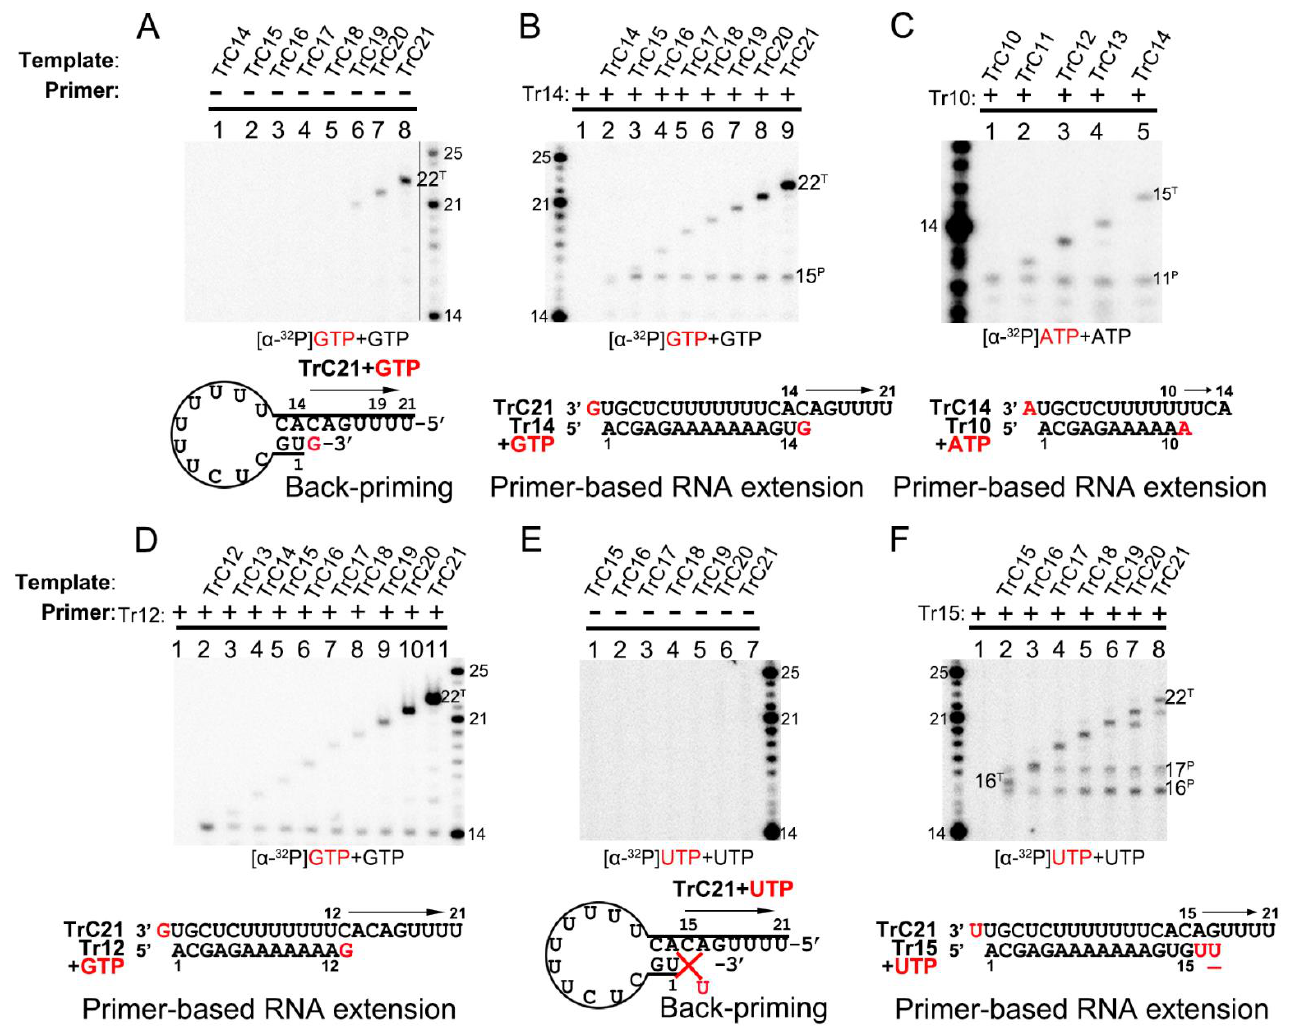
Figure 4. Terminal nucleotide(s) addition to the templates and primers by RSV polymerase. ( A ) Back-primer secondary-structure-based 3 (cid:48) terminal extension of the templates from TrC14 to TrC21 using GTP only. GTP at 50 µ M with 5 µ Ci of [ α -32P] GTP was used in the reaction mixtures. ( B ) Primer-based terminal extension of the templates from TrC14 to TrC21 with primer Tr14 and GTP only. GTP at 50 µ M with 5 µ Ci of [ α -32P] GTP was used in the reaction mixtures. ( C ) Primer-based terminal extension of templates from TrC10 to TrC14 with primer Tr10 in the presence of ATP. ATP at 50 µ M with 5 µ Ci of [ α -32P] ATP was used in the reaction mixtures. ( D ) Primer-based terminal extension of templates from TrC12 to TrC21 with primer Tr12 in the presence of GTP. GTP at 50 µ M with 5 µ Ci of [ α -32P] GTP was used in the reaction mixtures. The 5 (cid:48) hydroxyl RNA (RNA products extended from template or primer) migrates about 1 nt slower than 5 (cid:48) monophosphate RNA (RNA ladders) when the RNA length is 12–24 nts (See Section 3.2 in Results), leading to the product from primer Tr12 at the length of 13 nts close to the ladder 14 nts. ( E ) Back-primer secondary-structure- based 3 (cid:48) terminal extension of the templates from TrC15 to TrC21 using UTP only. UTP at 50 µ M with 5 µ Ci of [ α -32P] UTP was used in the reaction mixtures. Since U can not pair with C, no products were detected. ( F ) Primer-based terminal extension of the templates from TrC15 to TrC21 with primer Tr15 and UTP only. UTP at 50 µ M with 5 µ Ci of [ α -32P] UTP was used in the reaction mixtures. The UTP in the wobble base pair G-U is underlined. The superscript labels indicate that the band is generated from primer ( P ) or template ( T ). The red G or GTP, A or ATP, and U or UTP indicate radiolabeled GTP, ATP, and UTP,